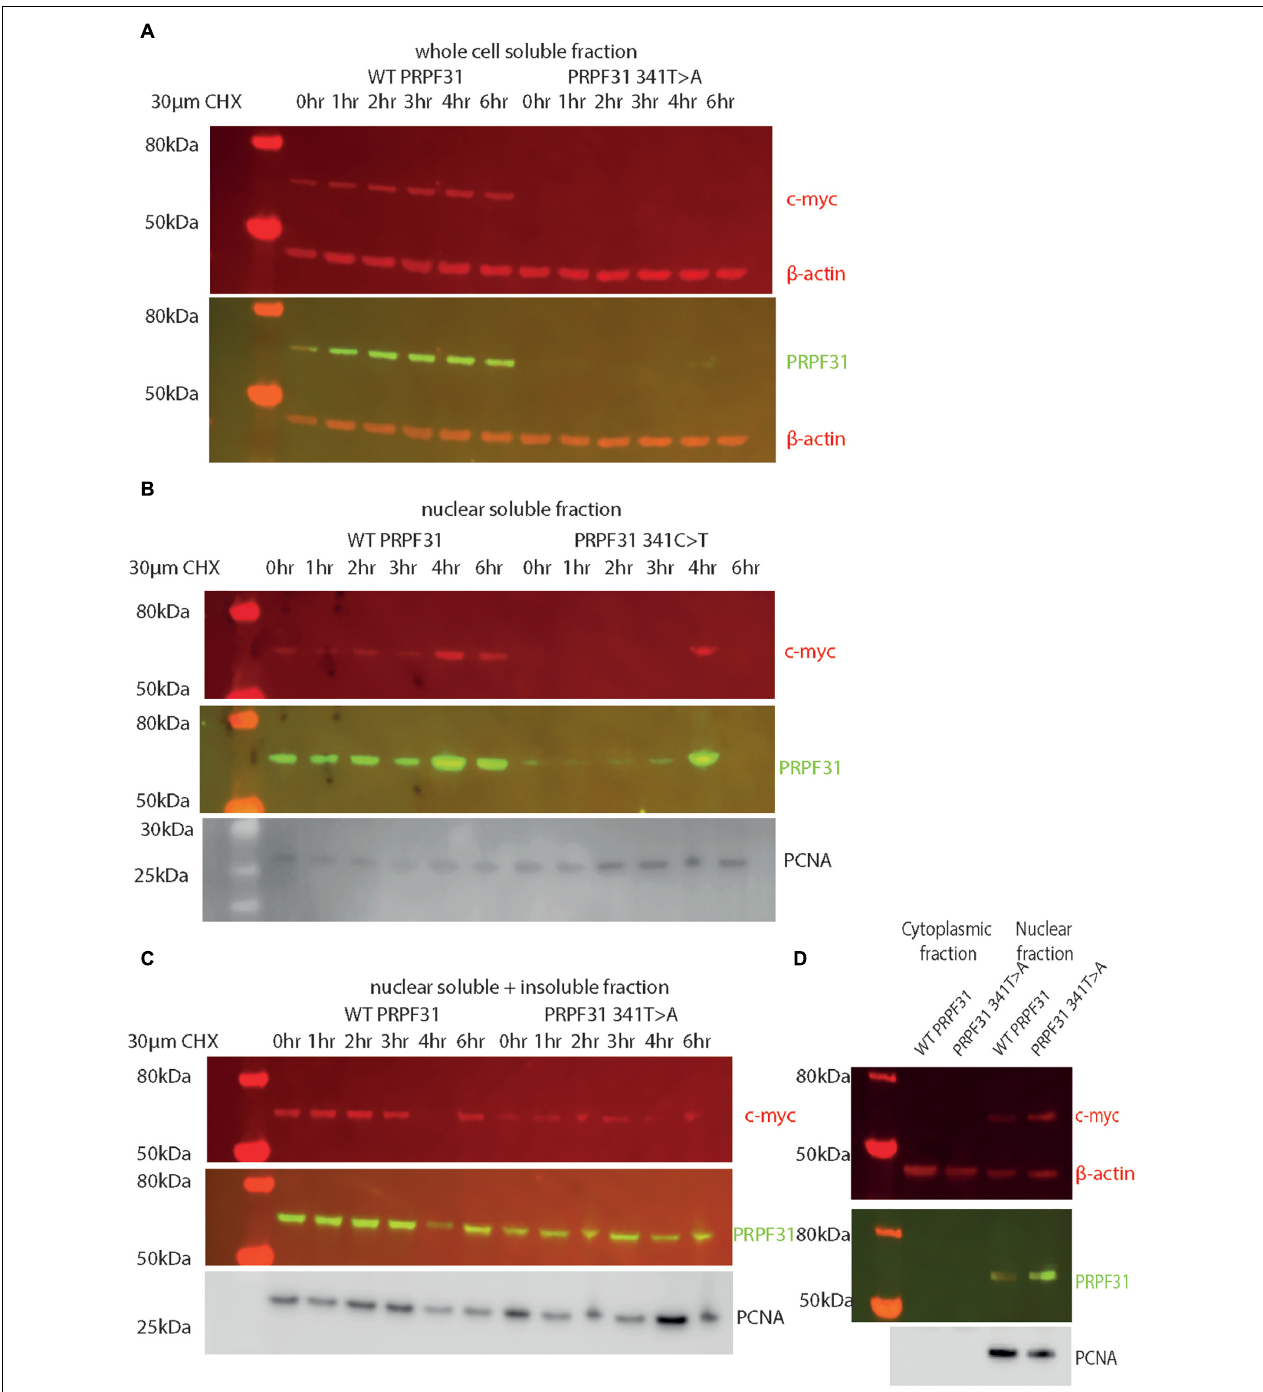
FIGURE 8 | Western blots of protein extracted from HEK293 cells transfected with wild-type or c.341T > A PRPF31 tagged with c-myc. (A) Cells treated with 30 µ M cycloheximide (CHX) over 6 h, and soluble protein extracted from the whole cell showed stable levels of wild-type protein expression across the time course, and complete absence of mutant protein in the soluble whole cell fraction. β -actin is cytoplasmic loading control. (B) Cells treated with 30 µ M cycloheximide (CHX) over 6 h, and soluble protein extracted from the nucleus showed stable levels of wild-type protein expression across the time course, and extremely low levels of mutant protein in the soluble nuclear fraction, except where some insoluble protein was accidentally loaded (4 h). β -actin is cytoplasmic loading control. PCNA is nuclear loading control. (C) Cells treated with 30 µ M cycloheximide (CHX) over 6 h, and both soluble and insoluble protein extracted nucleus showed similar levels of wild-type and mutant protein expression and stability. PCNA is nuclear loading control marker. (D) Fractionation shows that both mutant and wild-type PRPF31 are localized to the nucleus. β -actin is cytoplasmic loading control, PCNA is nuclear loading control.